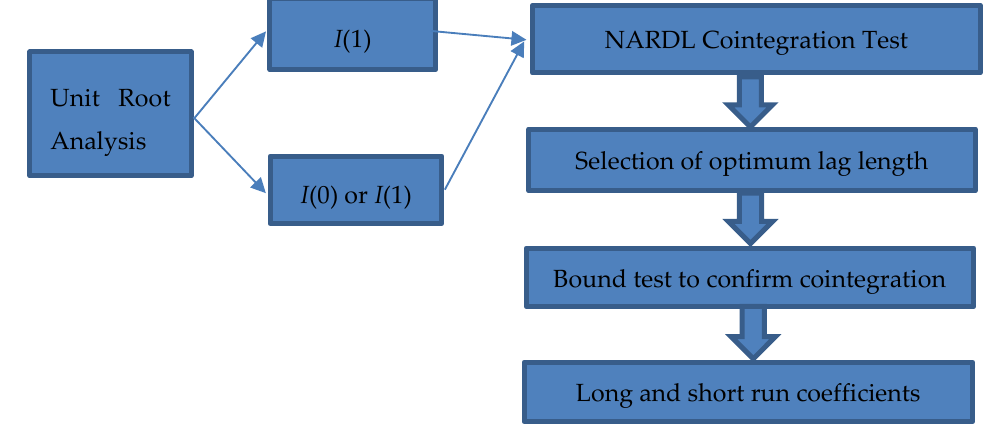
Figure 1. Methodological Framework.